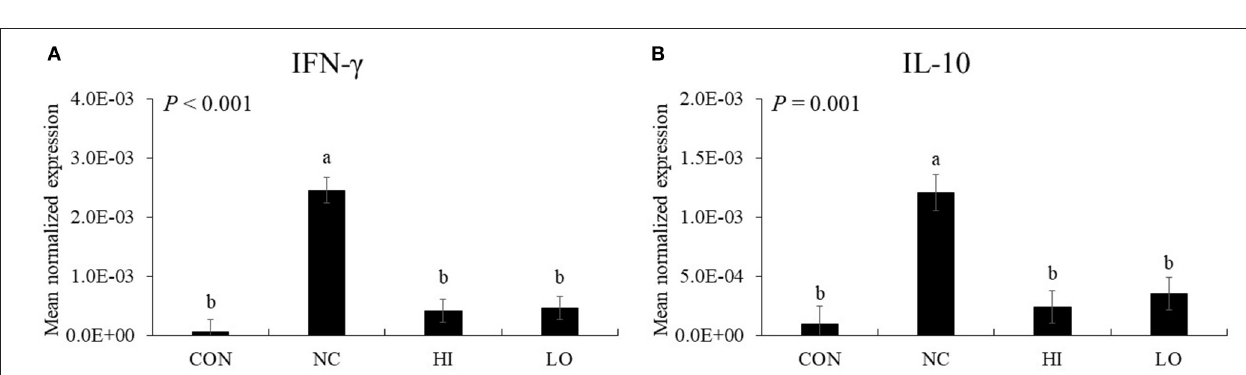
FIGURE 9 | Transcripts of Th1 cytokines in jejunum of chickens fed diet supplemented with maltol during infection with E. maxima in experiment 2. CON, basal diet; NC, basal diet for infected chickens; HI, maltol at 10.0 mg/kg feed; LO, maltol at 1.0 mg/kg feed; all chickens except CON were infected by oral gavage at day 14 with 1.0 × 10 4 oocysts/chicken of E. maxima. a,b Bars with no common letter differ significantly ( P < 0.05). Each bar represents the mean ± SEM ( n = 4). The data were collected at day 20 (6 days post-infection). Transcript levels of the cytokines were measured using quantitative RT-PCR and normalized to GAPDH transcript